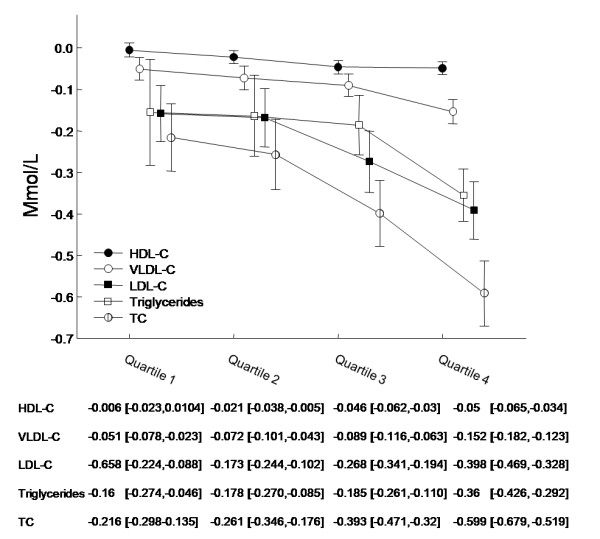
Mean lipid changes in patients without T2D according to BMI reduction quartiles. Lipid changes in patients without T2D stratified according to BMI reduction quartile (1-4). Quartile 1 represents the least reduction in BMI whereas quartile 4 represents the greatest. Mean lipid values are listed with 95% confidence intervals. All values are measured in mmol/L. 13 patients with unknown risk category were excluded.